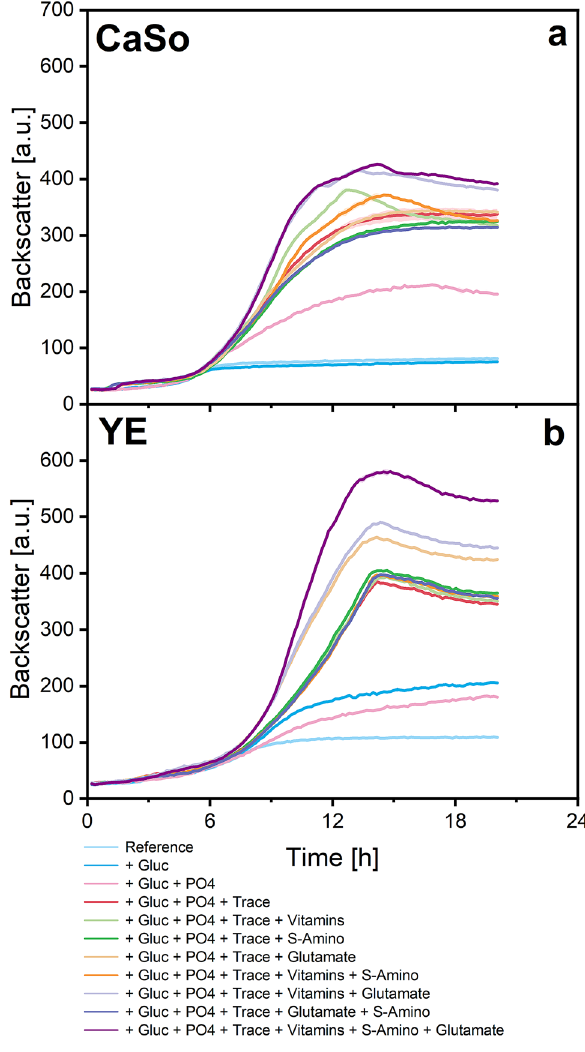
Figure 4. Backscatter data from microplate cultivation of S. pasteurii in supplemented complex media. (a) Data from casein and soy peptone (CaSo) medium supplementation. (b) Data from yeast extract (YE) medium supplementation. Dissolved oxygen (DO) data indicates oxygen limitation between 10 and 14 h for the cultivation with the three supplemented YE media showing the highest improvement (see Supplementary Figure S7 online). This explains slightly linear growth during this period. Components are reported as follow: glucose Gluc , K 2 HPO 4 PO4 , trace elements Trace , thiamine-HCl and nicotinic acid Vitamins , L-methionine and L-cysteine S-amino , triple glutamate group Glutamate . Average pH of all cultures: 9.15 ± 0.60. Culture conditions: 48-well Flower Well Plate, filling volume 800 µ L, shaking frequency 1200 rpm, shaking diameter 3 ◦ mm and temperature 30 C. Here, arithmetic mean values derived from biological replicates (N = 2) are shown. The error bands depict the standard